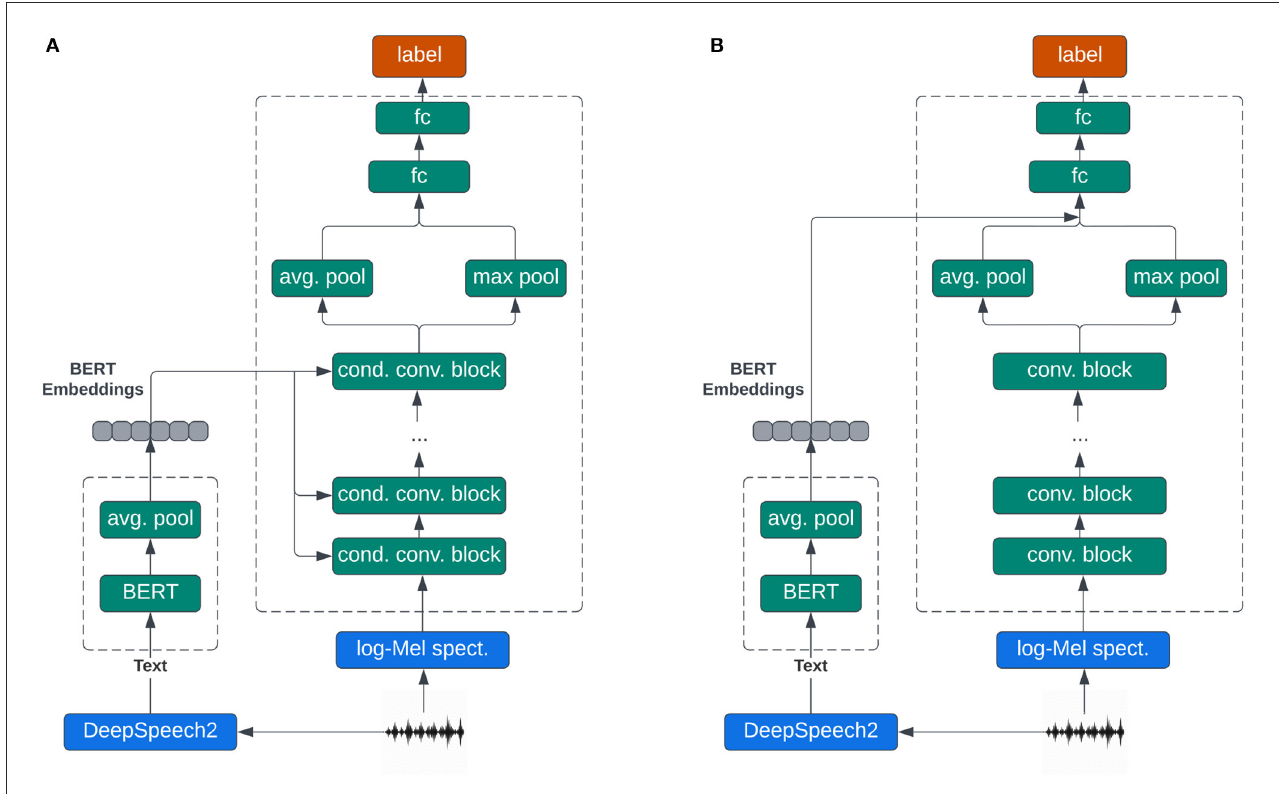
FIGURE1 Diagrams of the architectures used in this work illustrating the processing of a single utterance. (A) MFCNN14: Multistage fusion architecture. (B) SFCNN14: Single-stage fusion architecture. The same architecture was used for the baseline CNN14, but without the fusion.